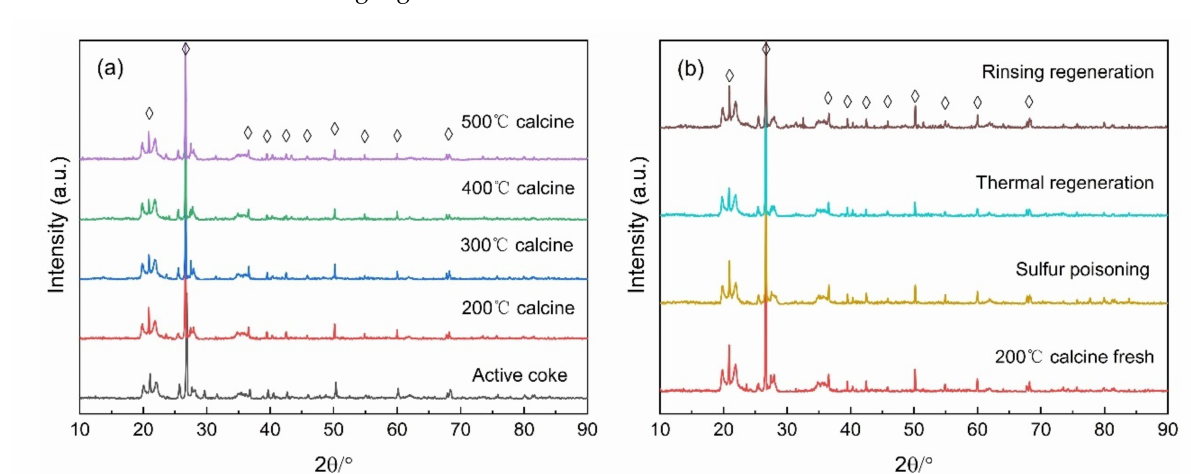
Figure 6. XRD pattern of ( a ) different calcination temperature catalysts, and ( b ) various regeneration mode